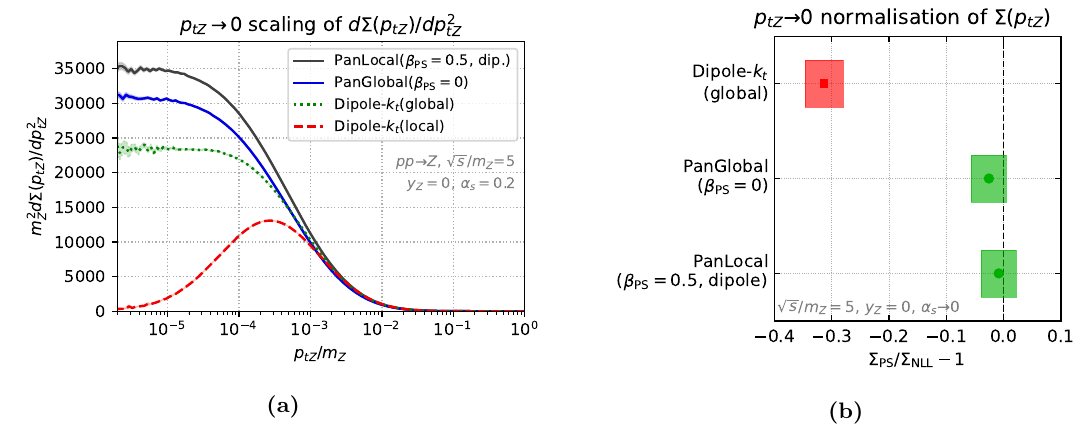
Figure 6. (a) m 2 d Σ( p tZ ) /dp 2 , as determined with four showers. In QCD this quantity tends to Z tZ a calculable (non-zero) constant for p tZ → 0 [15]. (b) For the three showers that tend to a non-zero constant, the plot shows the α s → 0 limit of the deviation of that constant relative to the NLL expectation, with the usual (red) green colour coding for (dis)agreement with